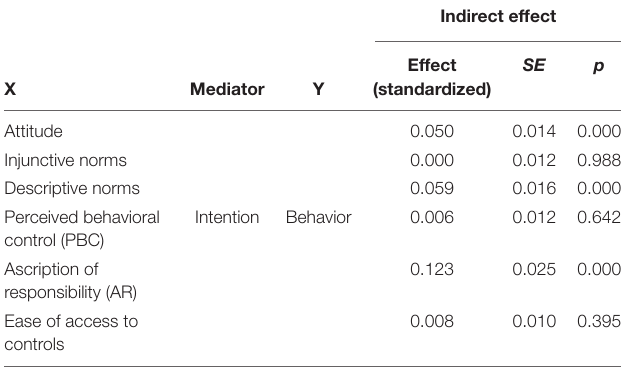
TABLE 5 | Indirect effects on Behavior for single-person